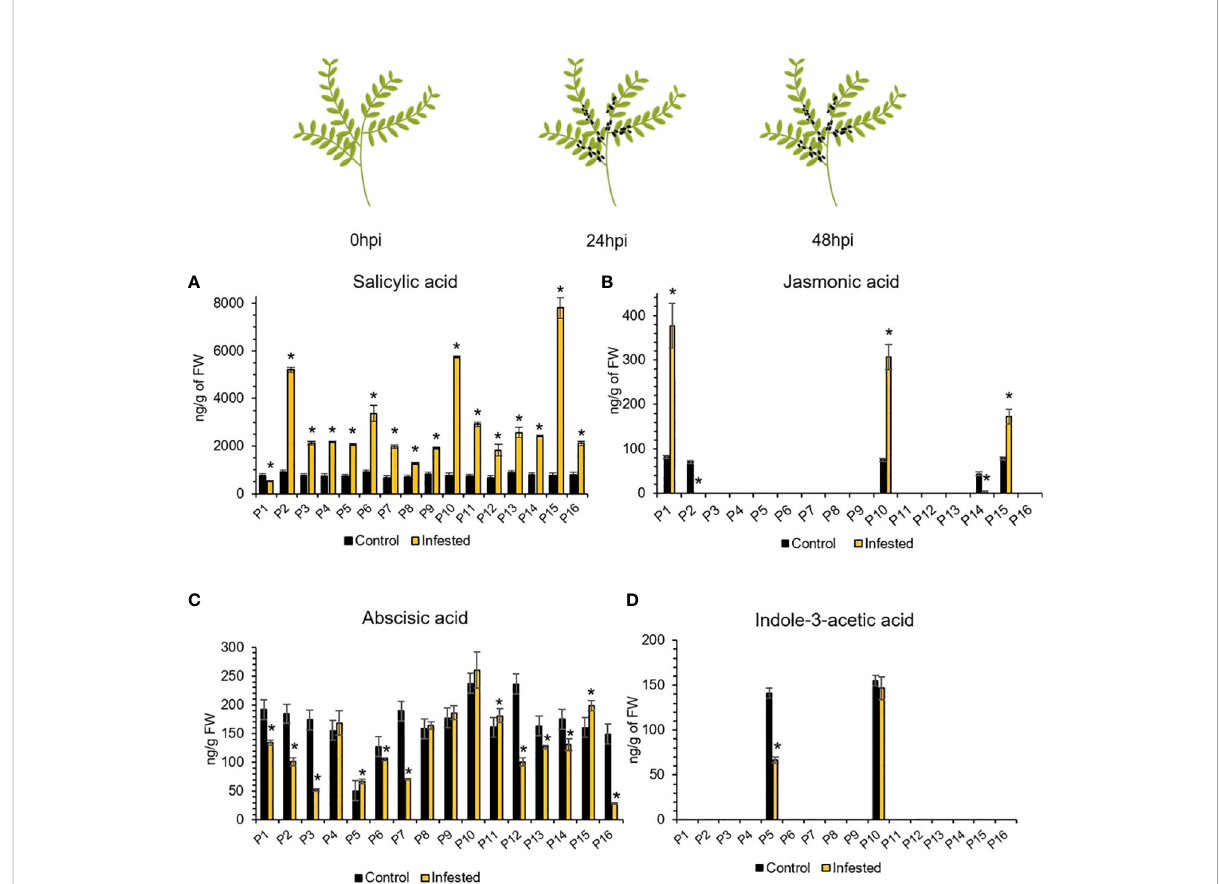
FIGURE 5 Relative abundance of (A) SA, (B) JA, (C) ABA, and (D) IAA at 48hpi compared to 0hpi. Accessions of similar phytohormonal abundance between control and 48hpi are considered unchanged according to Tukey ’ s HSD ( a=0.05 ). The asterisk (*) indicates statistically signi fi cant differences ( p<0.05 ). Omitted bars indicate values below the limits of quanti fi cation (LOQs) of the